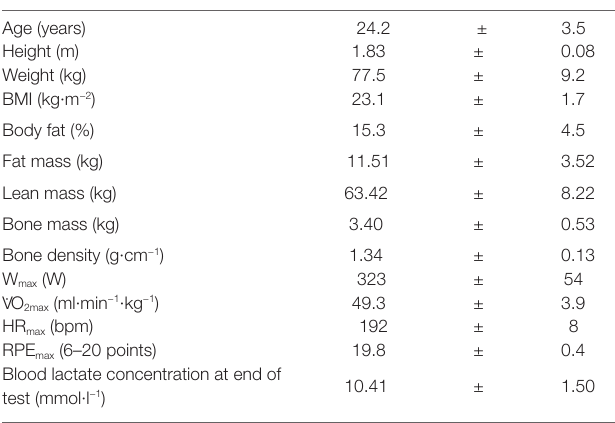
TABLE 1 | Participant characteristics ( n =